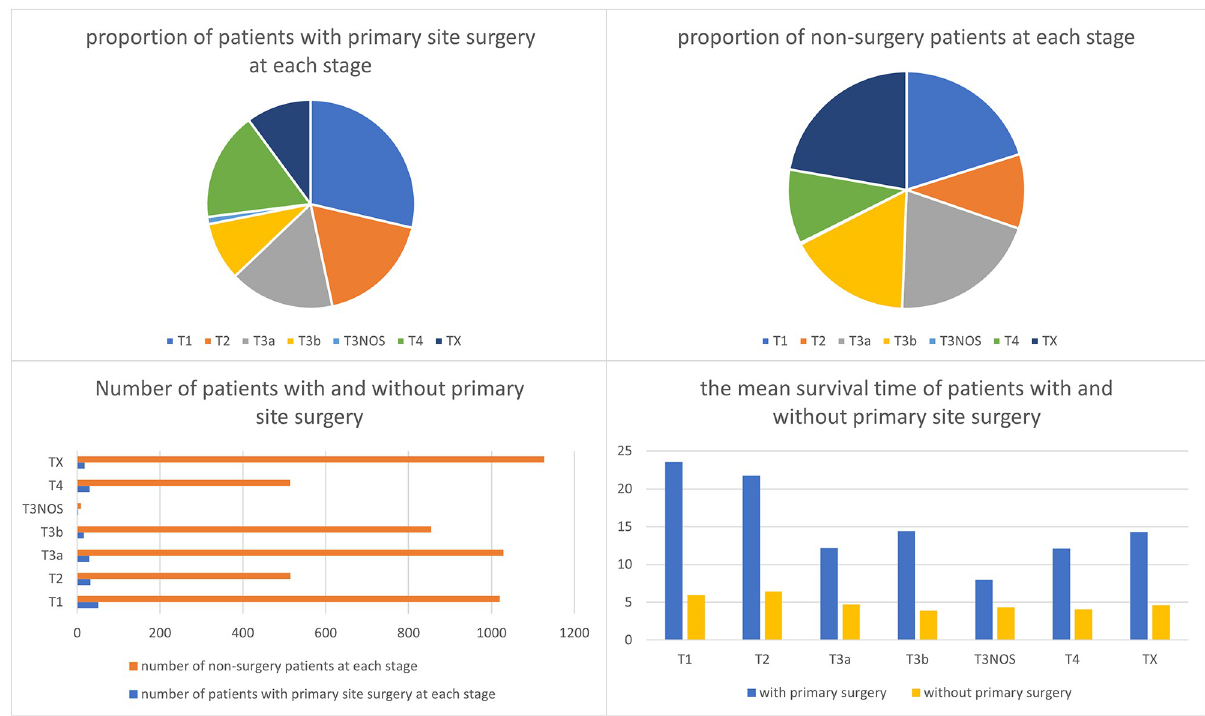
Fig 7. Outcome of the primary site surgery. In the bar chart of mean survival time (months), the bars representing patients undergone primary site surgery were on the left and non-primary site surgery were on the right.